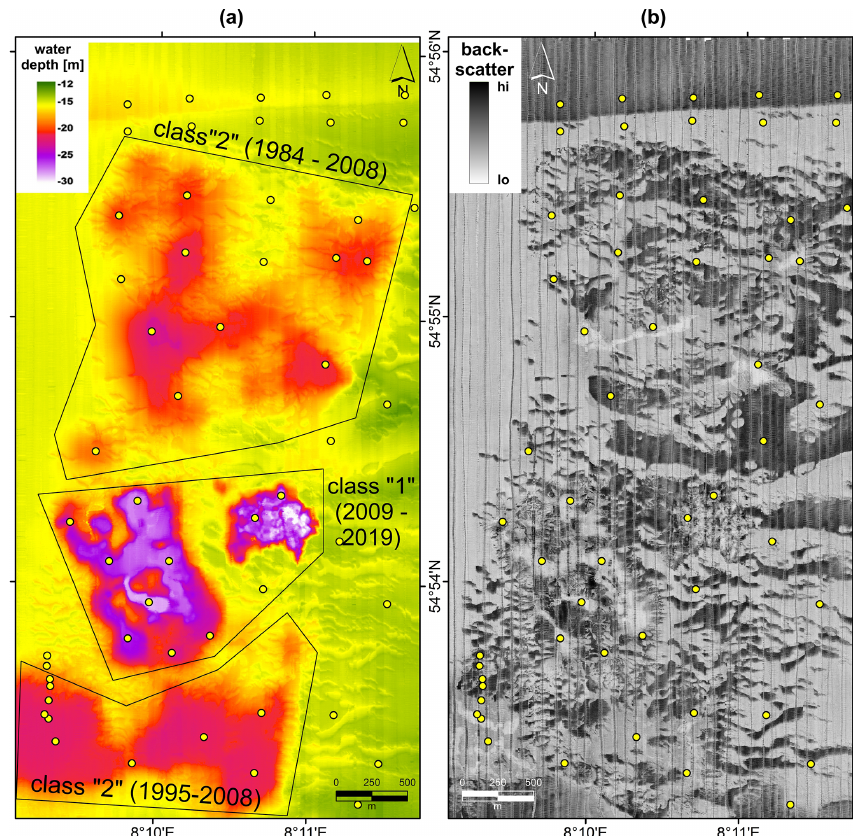
Figure 2. Results of the hydroacoustic survey along 55 N–S transects executed in January 2019. (a) Post-processed bathymetric map of the study site measured with a multibeam echo sounder; class “1”: sites where sediment was extracted during the past 10 years (1984–2008); class “2”: sites where sediment extraction was terminated at least 10 years prior to the sampling (2009–2019); class “0”: control sites which are directly unaffected by dredging (area outside the boxes). (b) Backscatter response of the seafloor recorded with side-scan sonar (here: 330kHz); dark grey: high backscatter; light grey: low backscatter. Surveyed transects become visible as the longish dark grey stripe in the side-scan mosaic proceeding in the N–S direction. Positions of grab sample stations are indicated by yellow